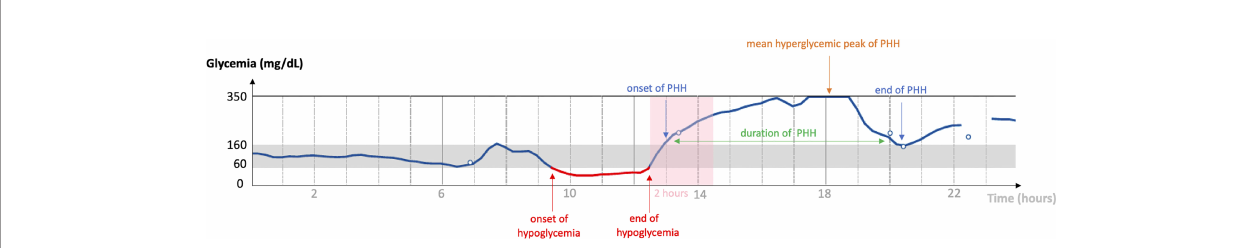
FIGURE 1 | Diagram of a typical PHH. Graphical representation of a continuous analysis of subcutaneous glucose (vertical axis) over a period of 24 hours (horizontal axis). The normoglycemia range is 60-160 mg/dL. In this example: end of hypoglycemia at 12:30 p.m., onset of PHH at 1:00 p.m., PHH hyperglycemic peak at 350 mg/dL between 5:30 and 6:45 p.m., end of PHH at 8:30 p.m. Hyperglycemia occurred less than 2 hours after the end of hypoglycemia; PHH lasted for 7 hours and 30 minutes. PHH: post-hypoglycemic